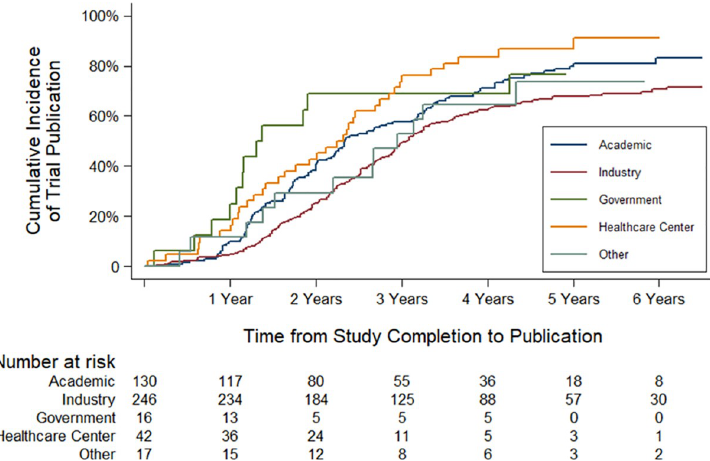
Fig 2. Time to publication of rare disease trials. Cumulative incidence of publication for rare disease trials using Kaplan-Meier methods. Of the trials, 33.5% were published by 2 years and 68.5% by 4 years, with a median time to publication of 2.2